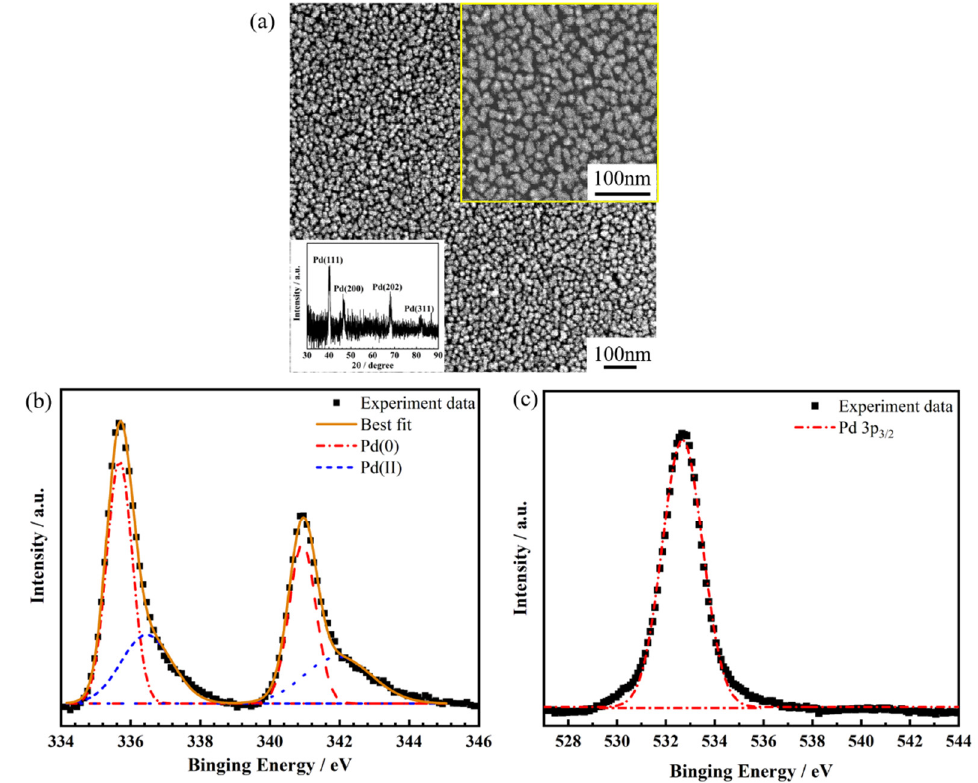
Figure 8. ( a ) SEM image of the prepared particles on Si (100) surface (The bottom-left inset is GIXRD spectrum, and top-right inset is high magnification). ( b ) and ( c ) experimental and fitted Pd 3d and spectrum, and top-right inset is high magnification). ( b , c ) experimental and fitted Pd 3d and Pd 3p Pd 3p spectra, respectively. spectra,